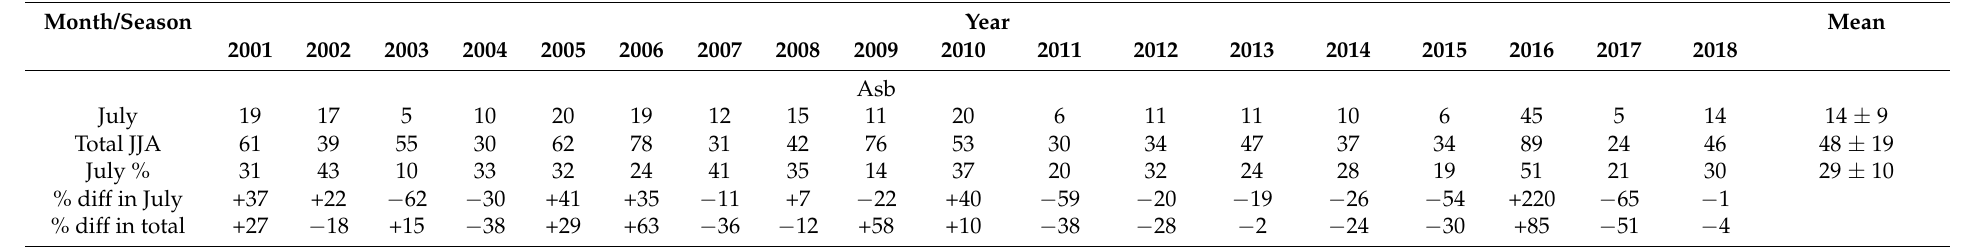
Table 2. Annual rainfall (mm) in July and total annual rainfall in JJA from 2001 to 2018 over Assab (Asb) with the mean calculated. The percentage amount of rainfall in July, the percentage difference in July, and total rainfall from the mean (2001–2018) for each year are also given. − indicates % deficit and + denotes % excess of the mean rainfall in July and for the season.